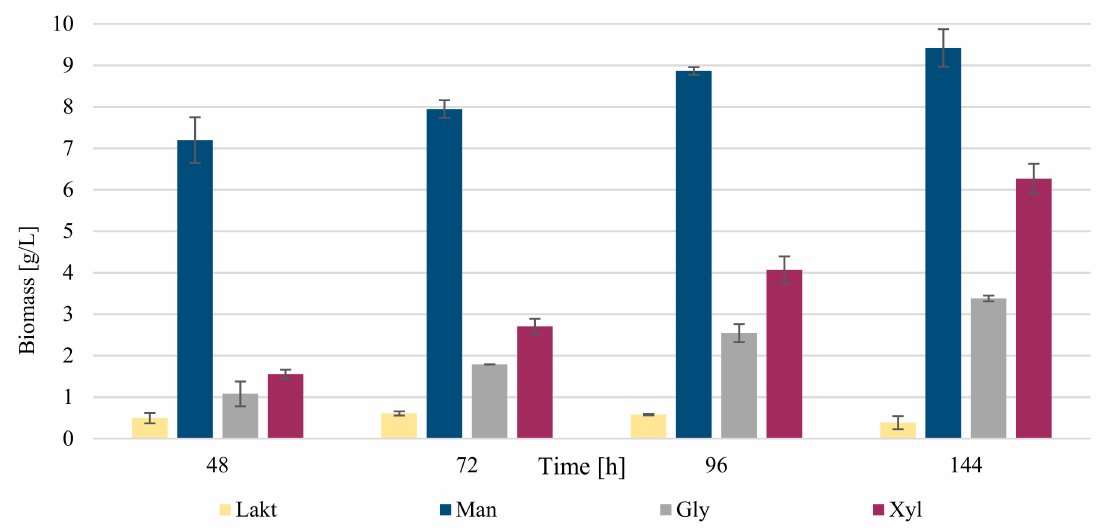
Figure 5. Biomass production with diverse carbon sources and with potassium nitrate as nitrogen source. Abbreviations: Lakt: lactose; Man: mannose; Gly: glycerol; Xyl: